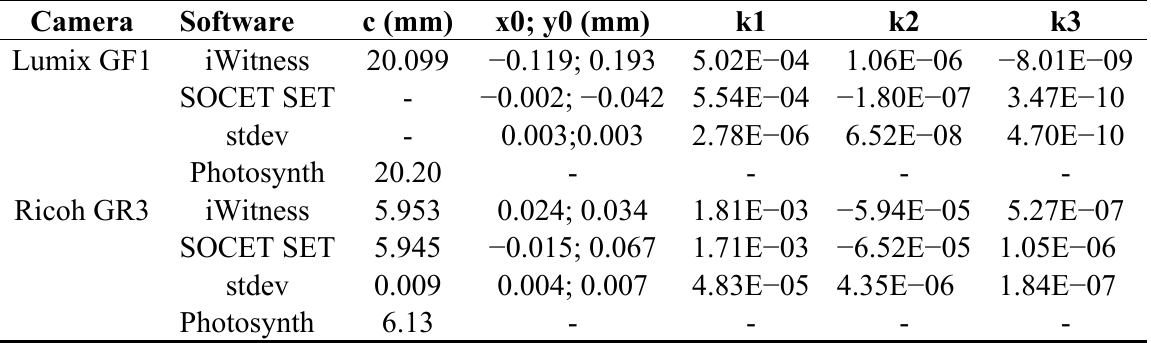
Table 1. Interior orientation and radial distortion parameters by iWitness, SOCET SET and Photosynth. Principal point is given from the image center. For the SOCET SET processing also the standard deviations are